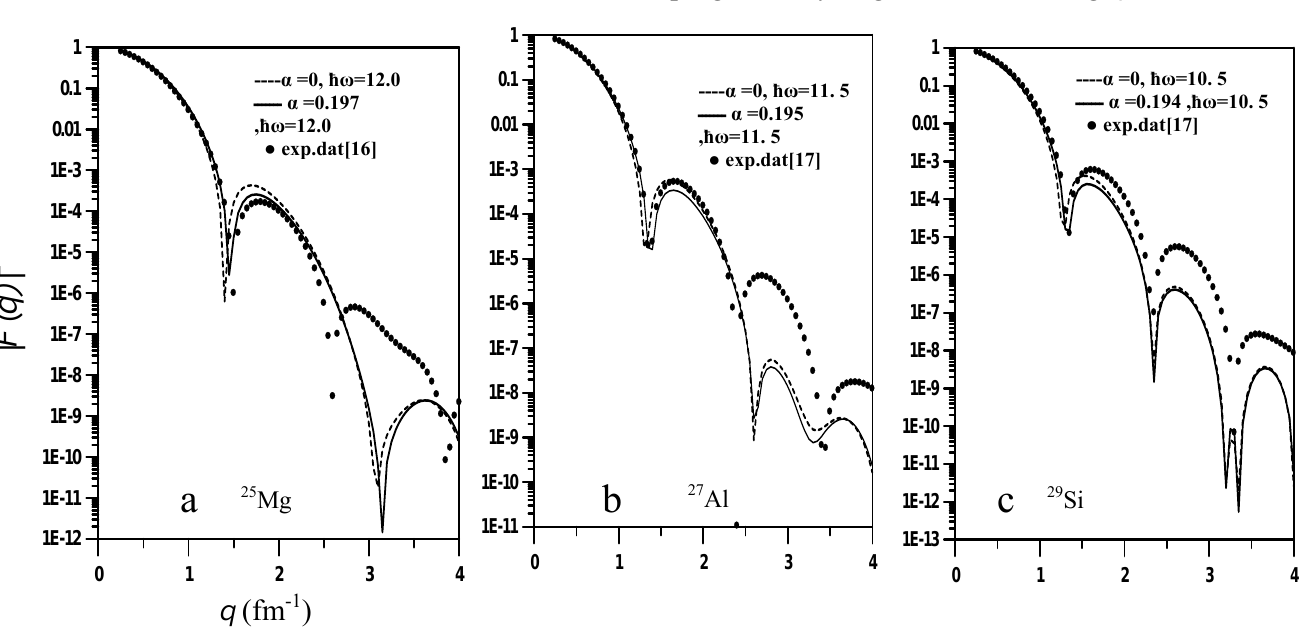
Fig.2: Elastic form factor for (a) 25 Mg, (b) 27 Al and (c) 29 Si nuclei. The dotted symbols are the experimental data of Ref [16,